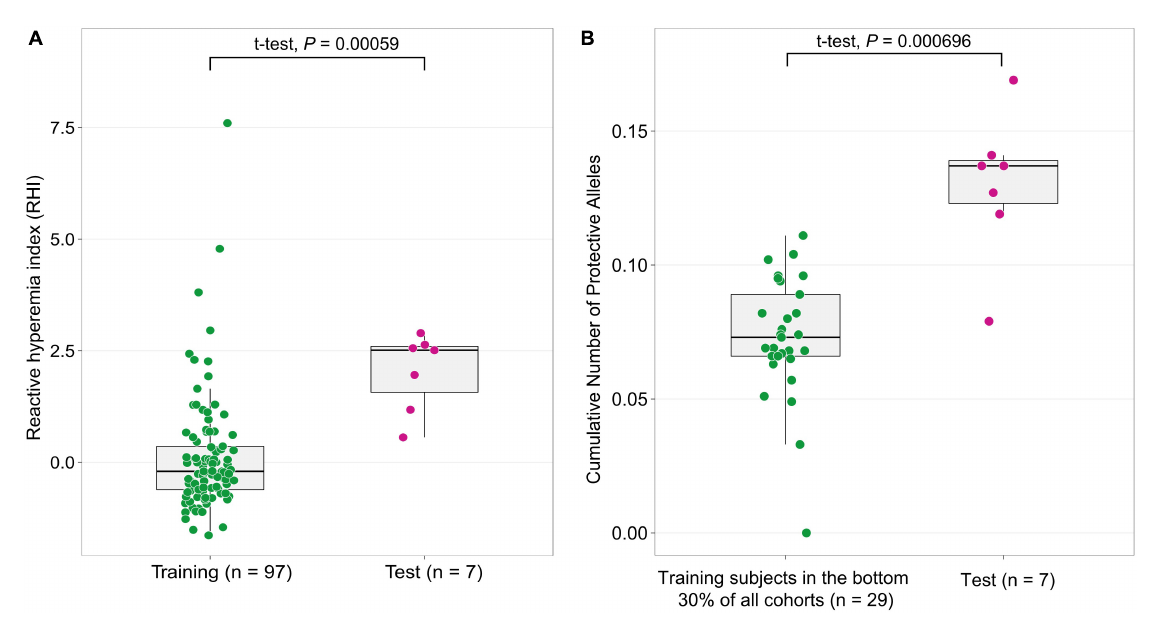
FIGURE2 The cumulative effect of candidate genes on an independent subject population. (A) The independent test population was selected with subjects with standardized RHI values in the top 30% ( n = 7, decelerated aging) of all Namgaram cohorts. (B) The distribution of the